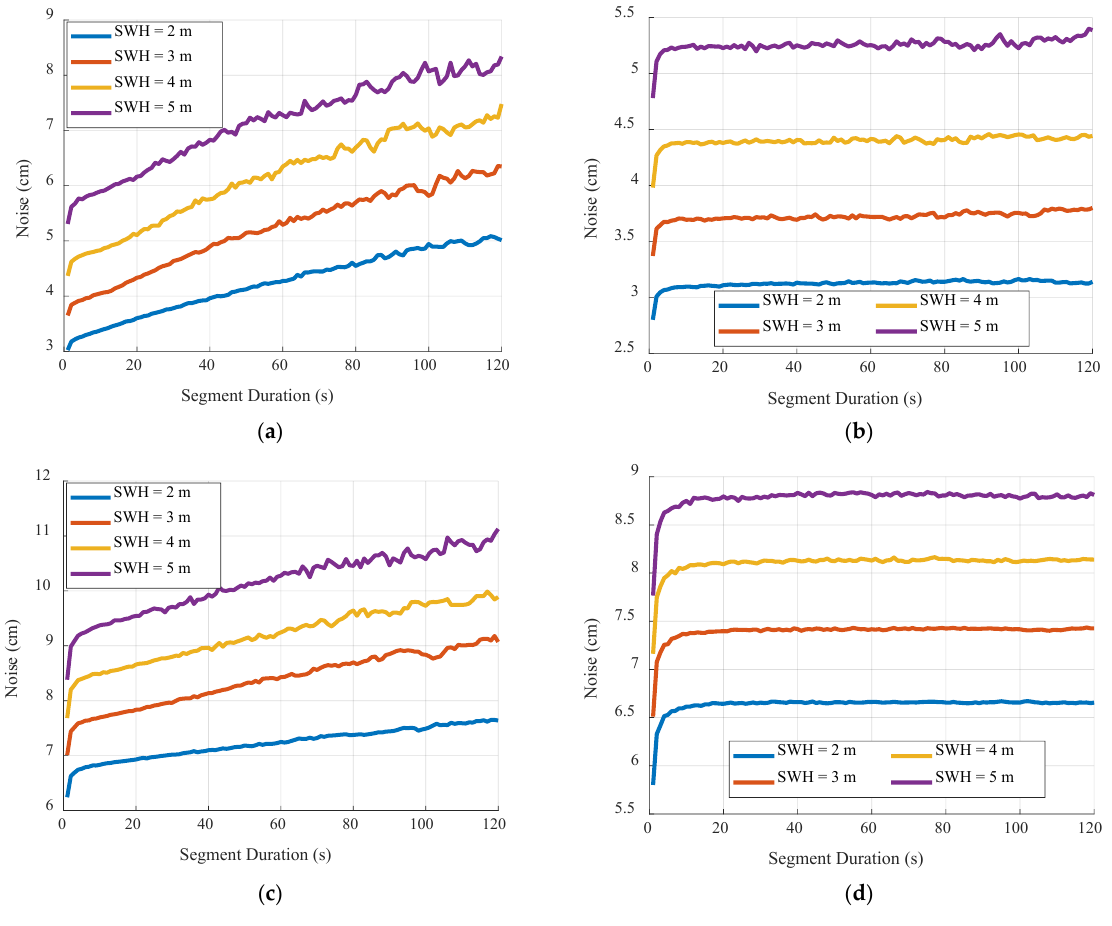
results using the DM are very consistent with the simulation data processing result. A slight difference in Figure 8b is that the estimated NL tends to be stable when the segment duration reaches 10 s, but not 20 s. This is because the NL of the HR mode is dramatically lower than that of the LR mode; therefore, the data length required to robustly estimate drastically in this time span. Therefore, it was reasonable to select the data sequence of this the NL is shorter. time length to estimate the altimeter noise level.